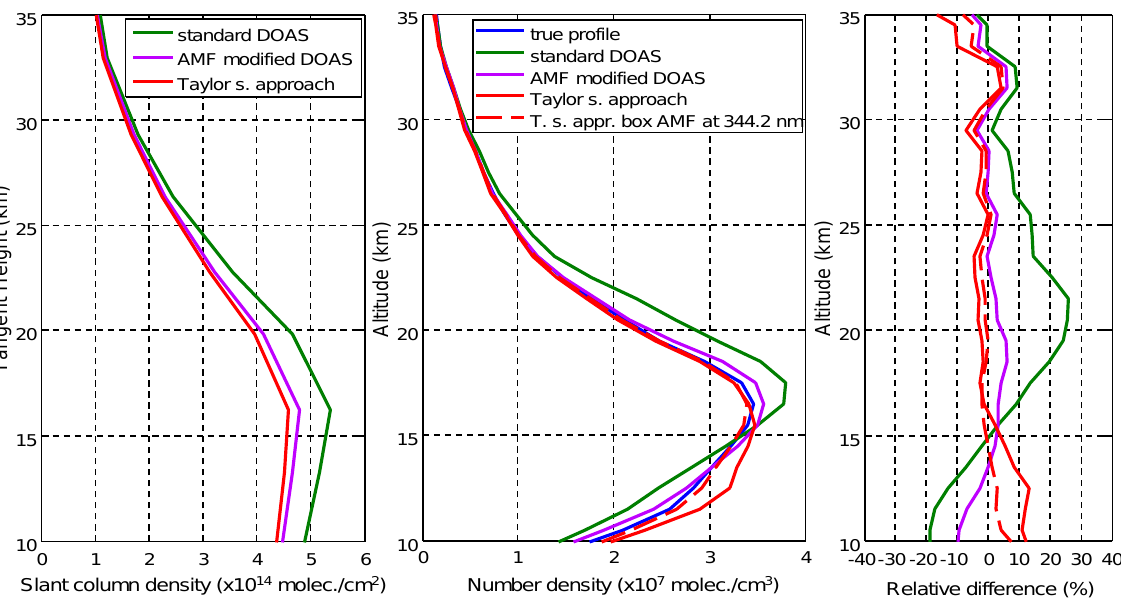
Fig. 4. BrO SCDs (left panel) and the vertical concentration profiles (middle panel) retrieved by different approaches (green: standard DOAS, violet: AMF modified DOAS, red: Taylor series approach, dashed red: AMFs for the Taylor series approach evaluated at a single wavelength of 344.2nm). The right panel shows the relative difference of the retrieved profiles to the true concentration profile applied for the